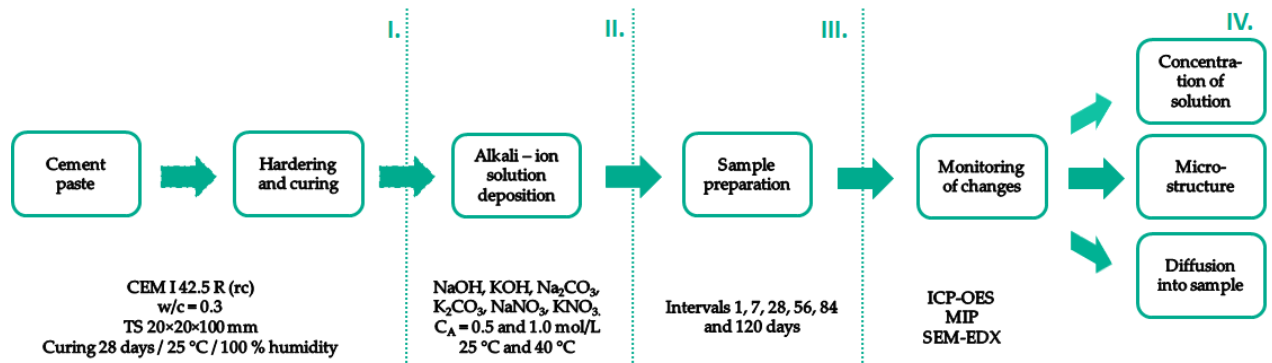
Figure 1. Schematic workflow of the experiment.